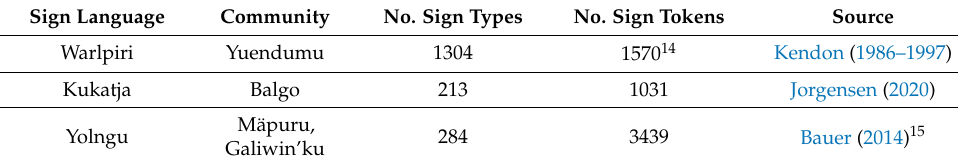
Table 1. Number of sign types and tokens in Warlpiri, Kukatja and Yolngu SLs. Sign